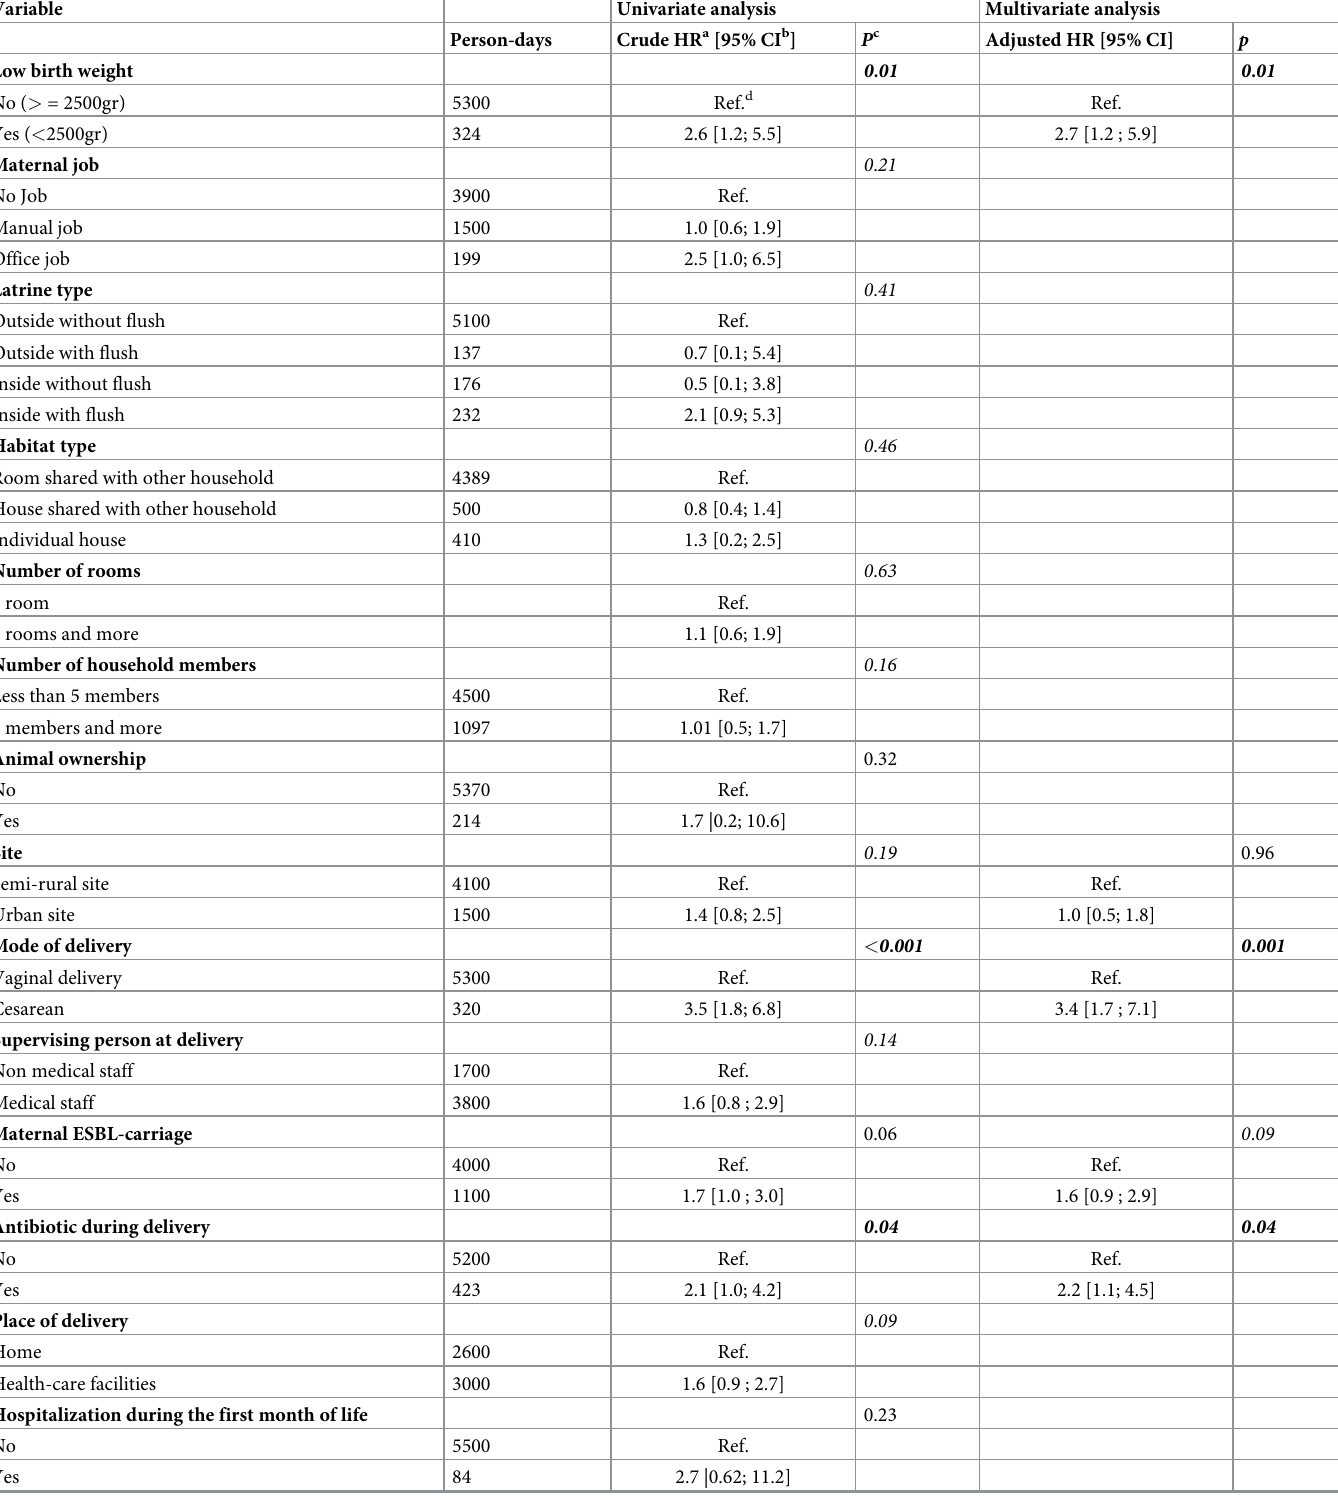
Table 2. Cox proportional hazard analysis of ESBL-PE